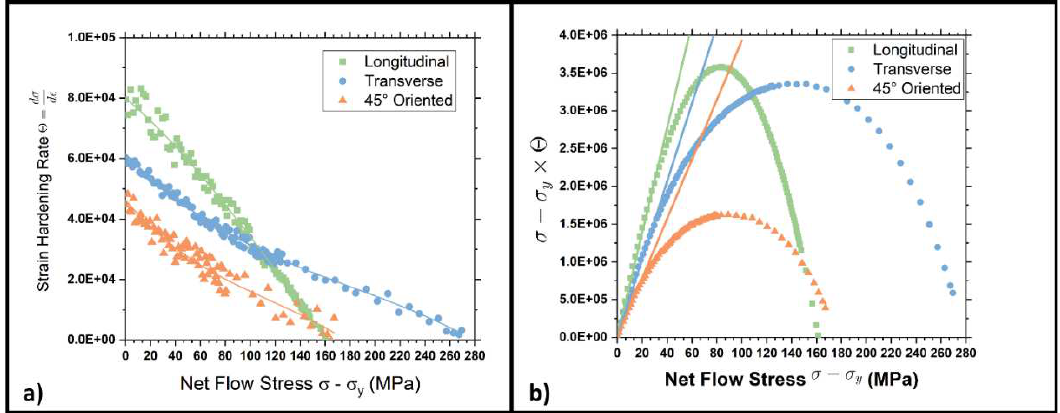
Figure 16. ( a ) Strain hardening rate and net flow stress plots and ( b ) (σ−Y)Θ versus net flow stress (σ−Y) for samples with 70% strain hardening level.